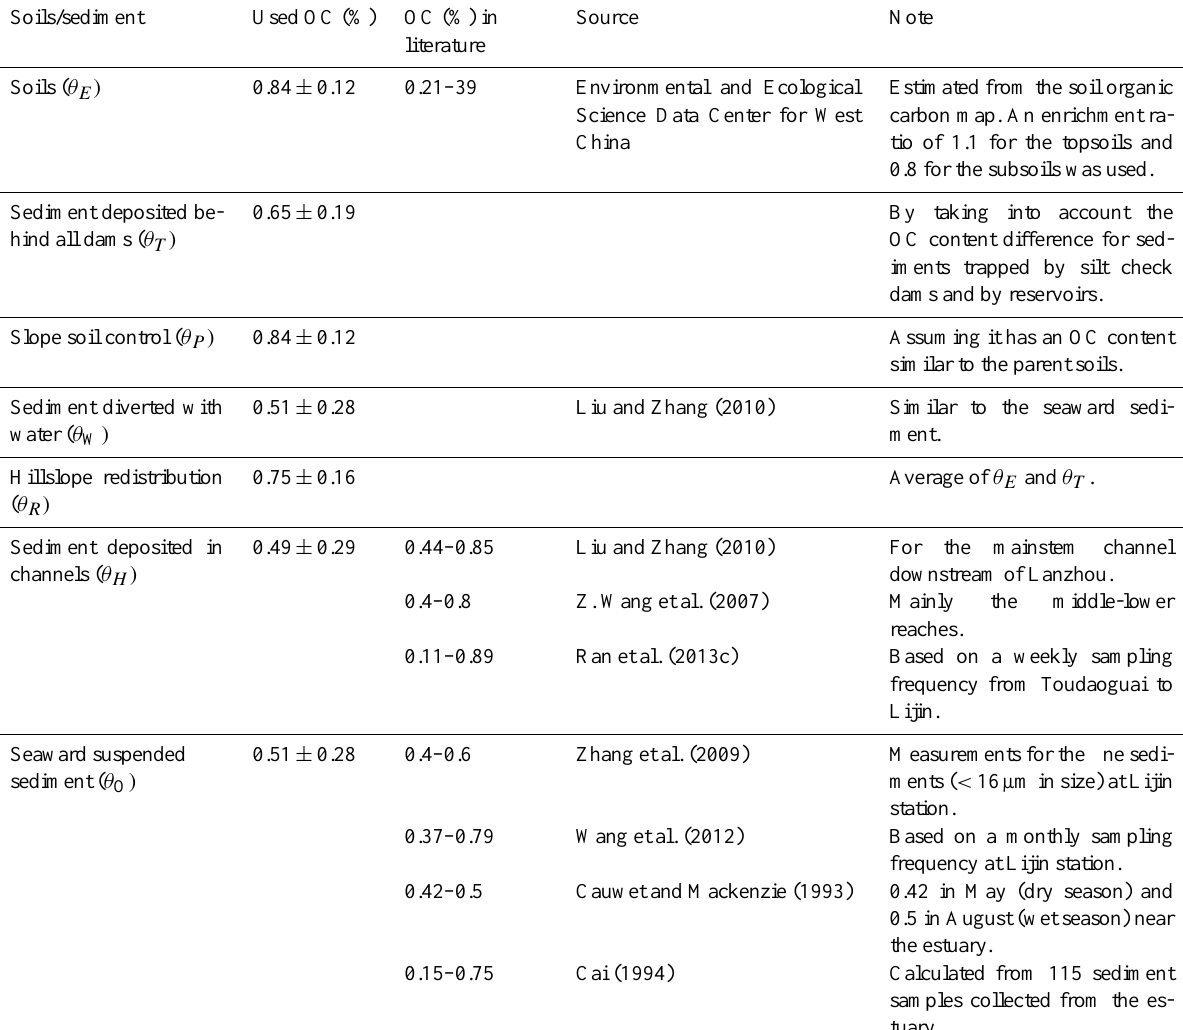
Table 3. A summary of organic carbon content of different budget terms. Soils/sediment